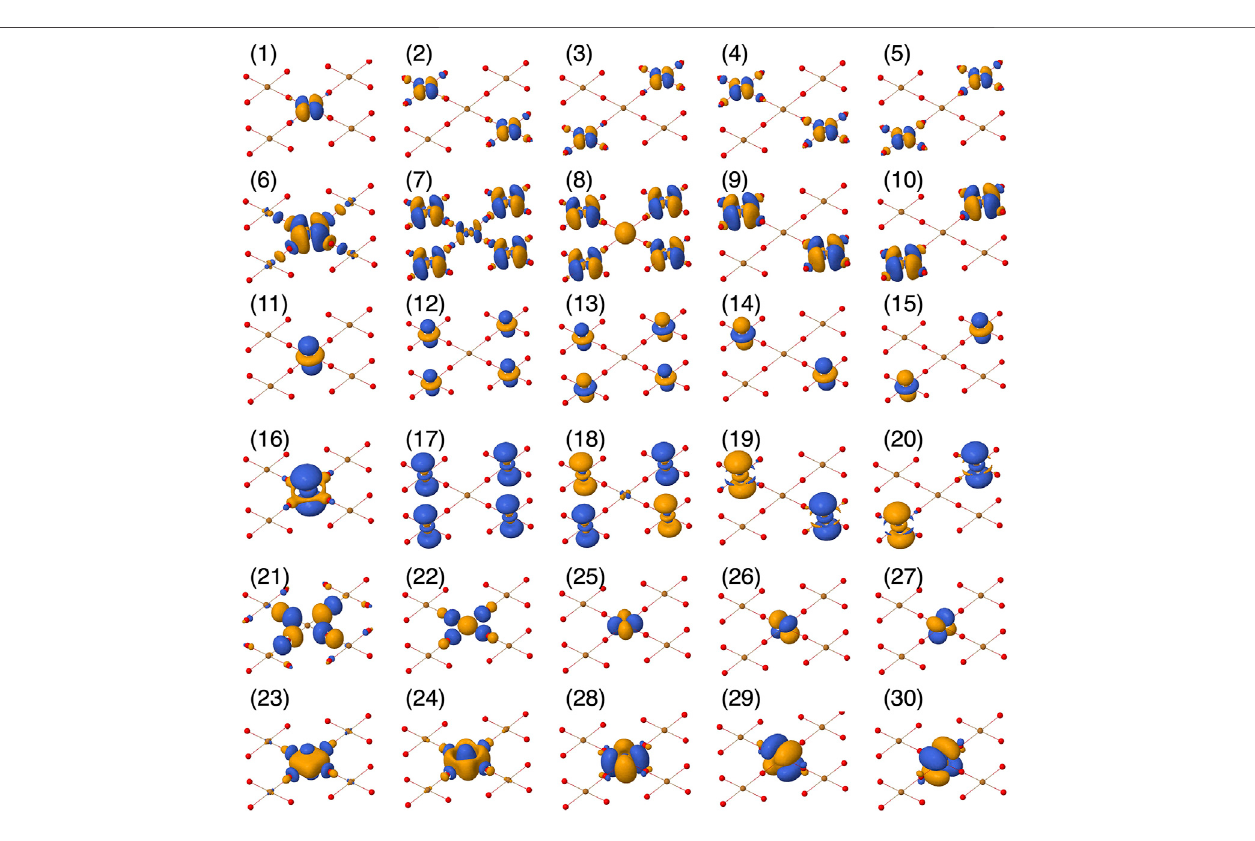
Frontiers in Physics |